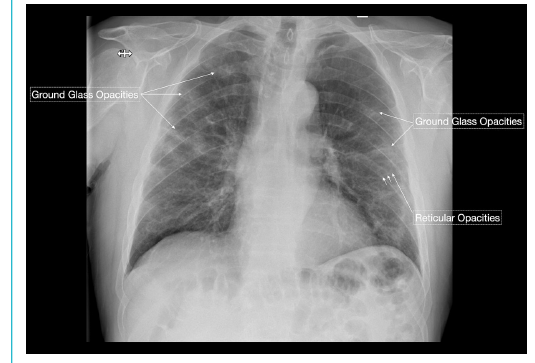
Figure 1: Schematic depiction of typical chest x-ray findings for COVID-19: bilateral, reticular and focal ground glass opacities or consolidative air space opacities in a peripheral and basal distribu- tion. Earlier stage disease shows predominantly ground glass opacities; with progression pre-existing ground glass opacities transform into consolidative air space opacities.